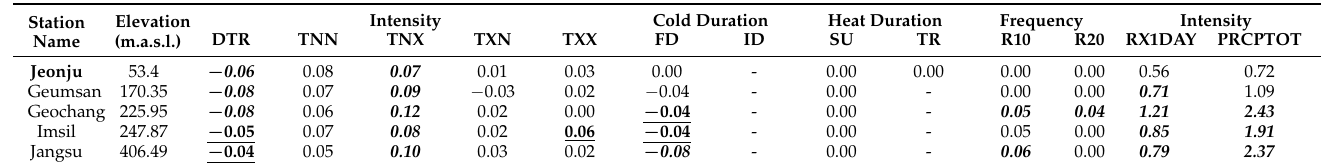
Table A16. Trend magnitudes for the month of October in the UGRB for 33 years (1988–2020).